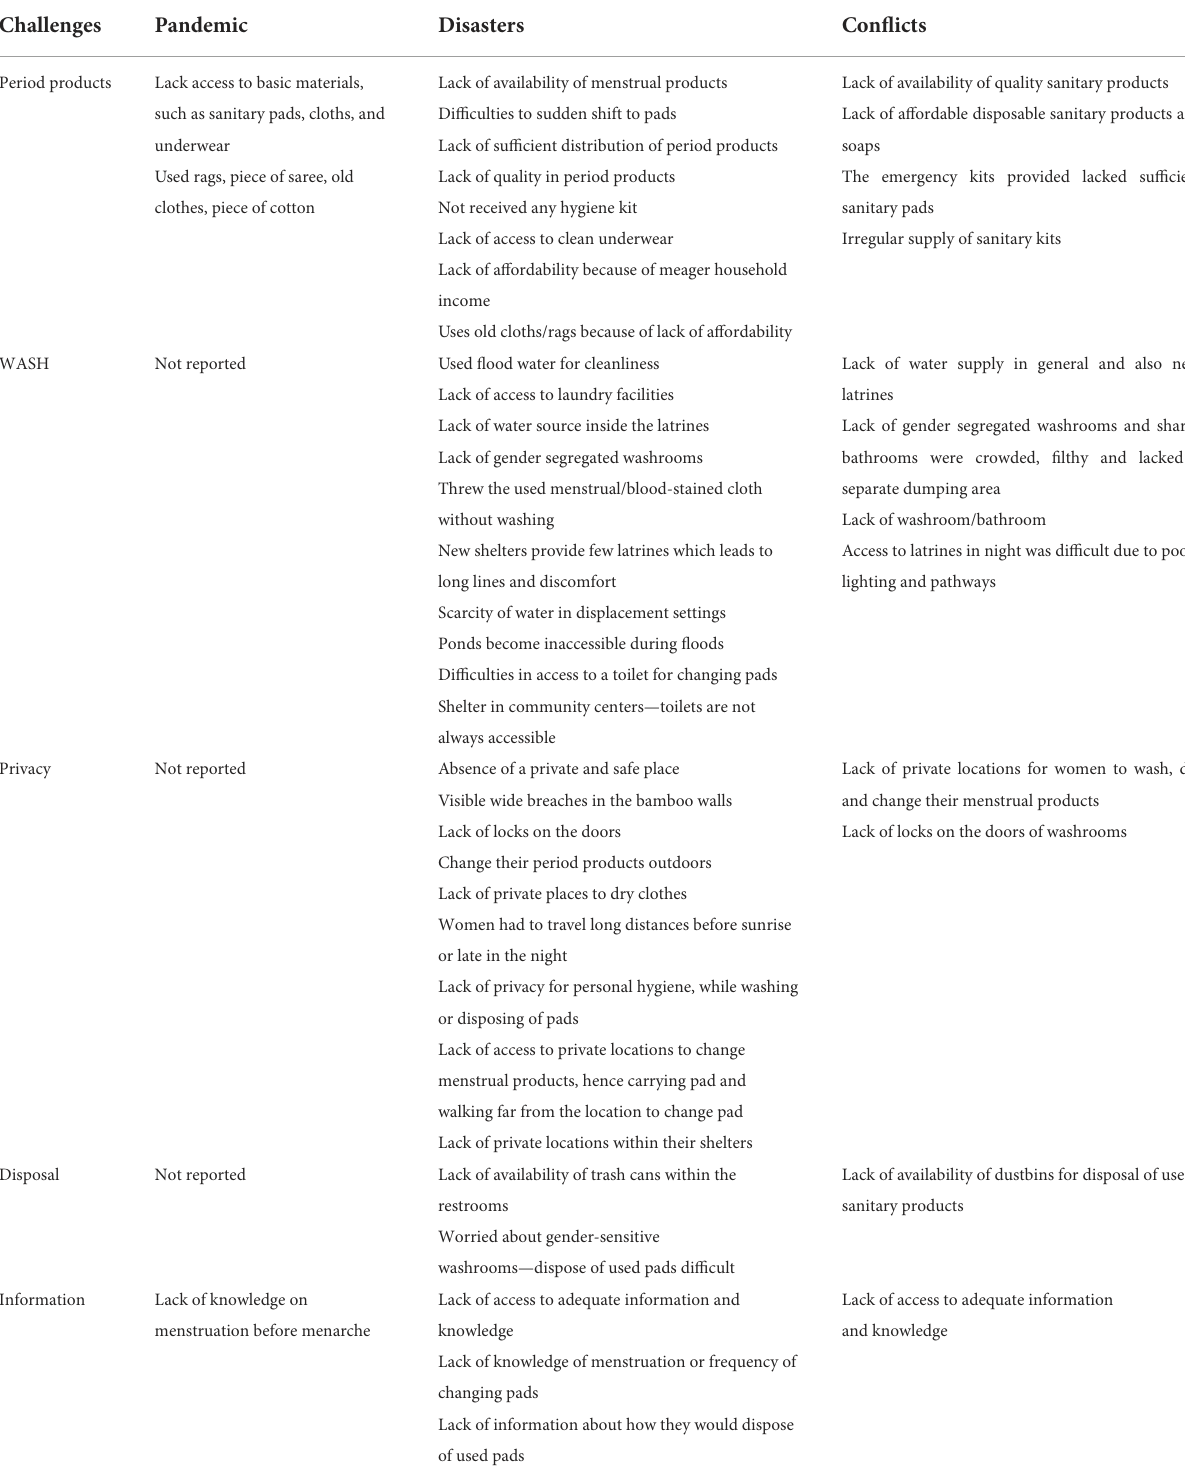
TABLE 2 Major challenges in managing menstrual hygiene during humanitarian